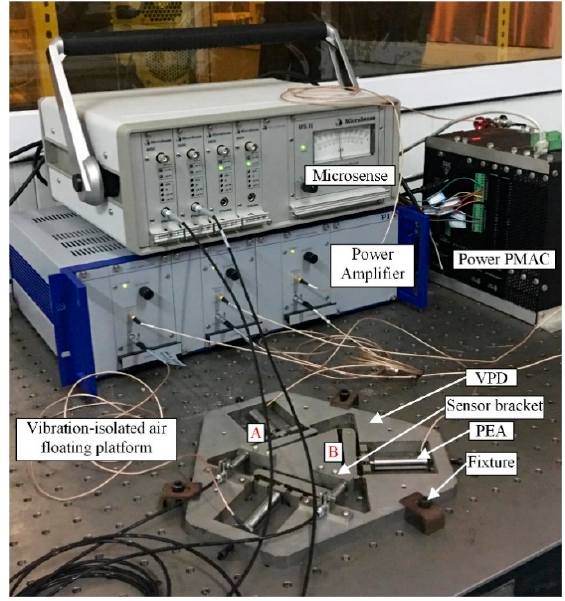
Figure 7. Testing experiment setup of the VPD.